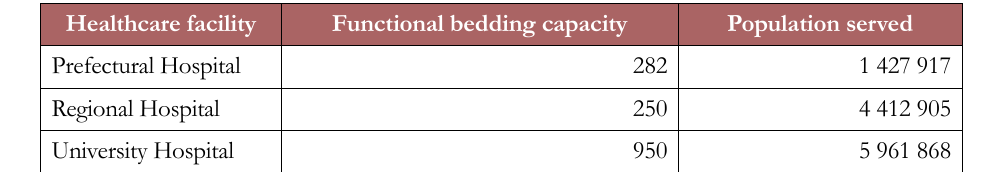
Table 1. Study sittings’